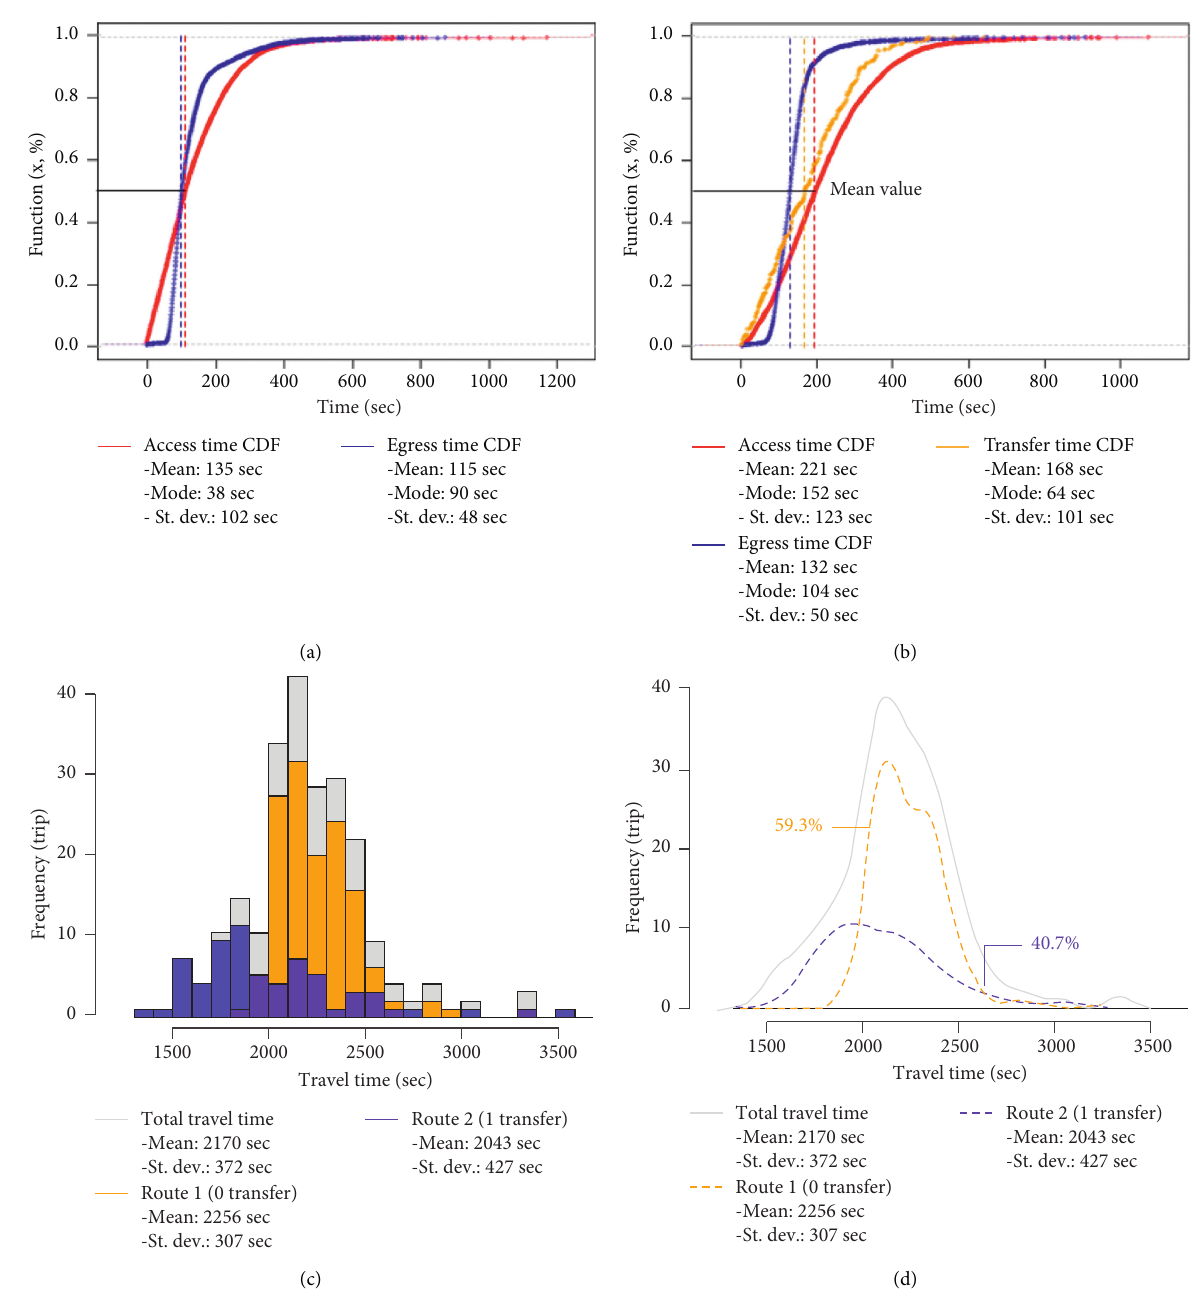
Figure 4: Estimation results of SNUE Station to Dangsan Station trips. (a) Cumulative distribution for no-transfer route. (b) Cumulative distributions for one-transfer route. (c) Histogram of travel time. (d) Distribution of travel